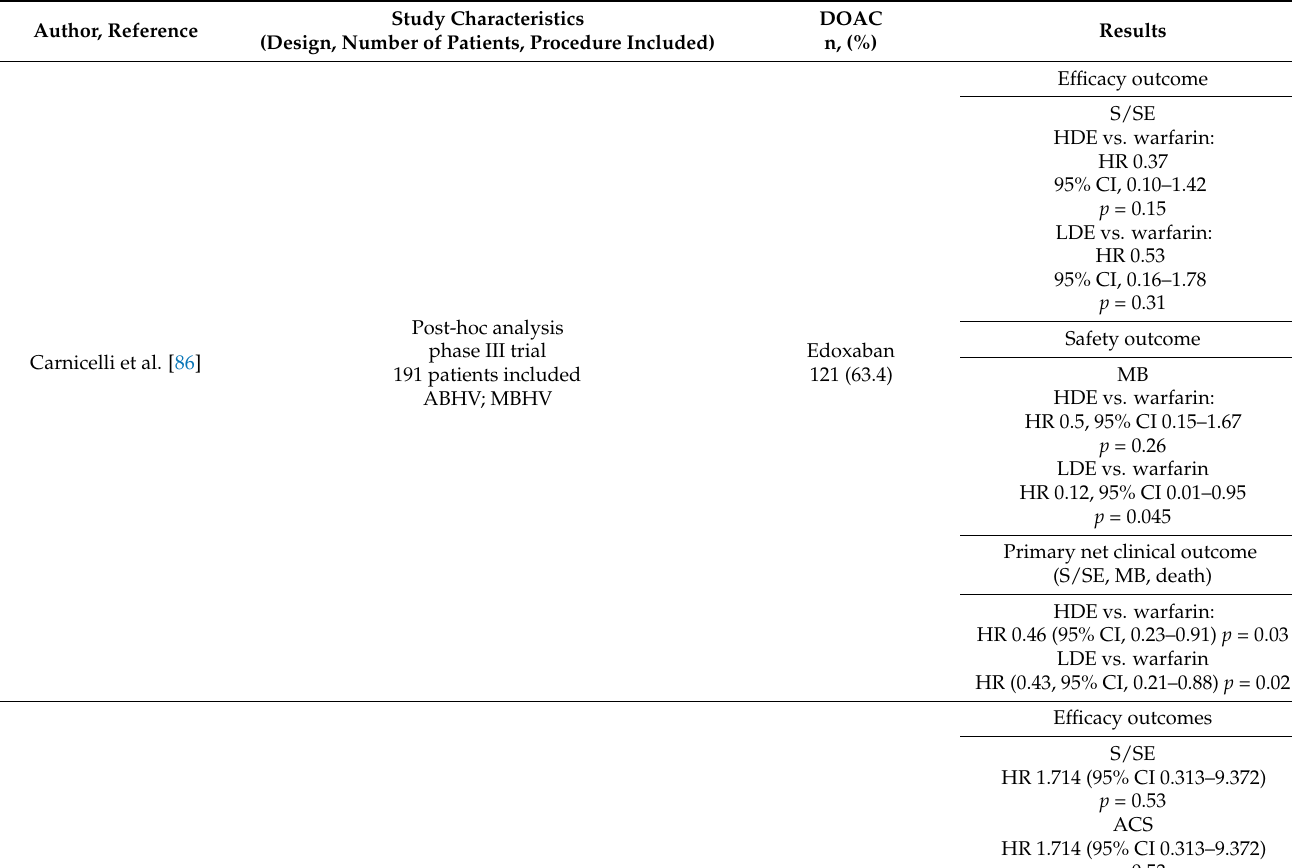
Table 5. Overview of the study characteristics comparing Direct oral anticoagulants with Vitamin K antagonist oral anticoagulants in AF patients with bioprosthetic valves or prior surgical valve